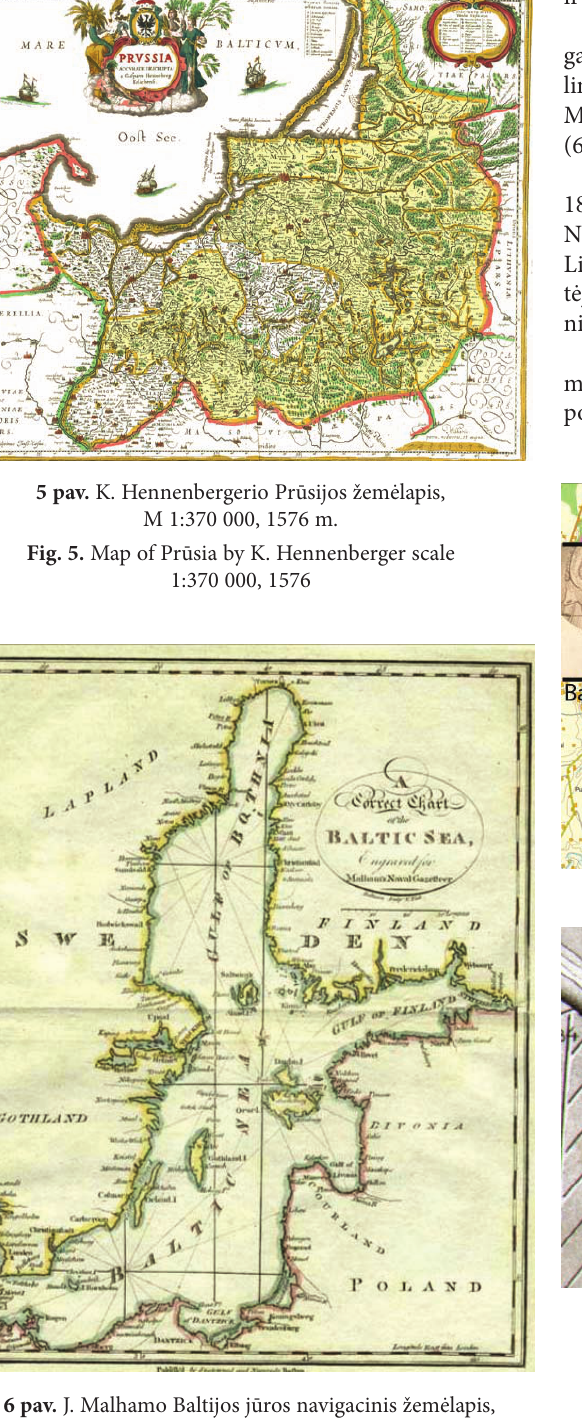
Fig. 6. Navigation map of Baltic sea by j. Malham 1804 (from Grace Galleries, Inc.)